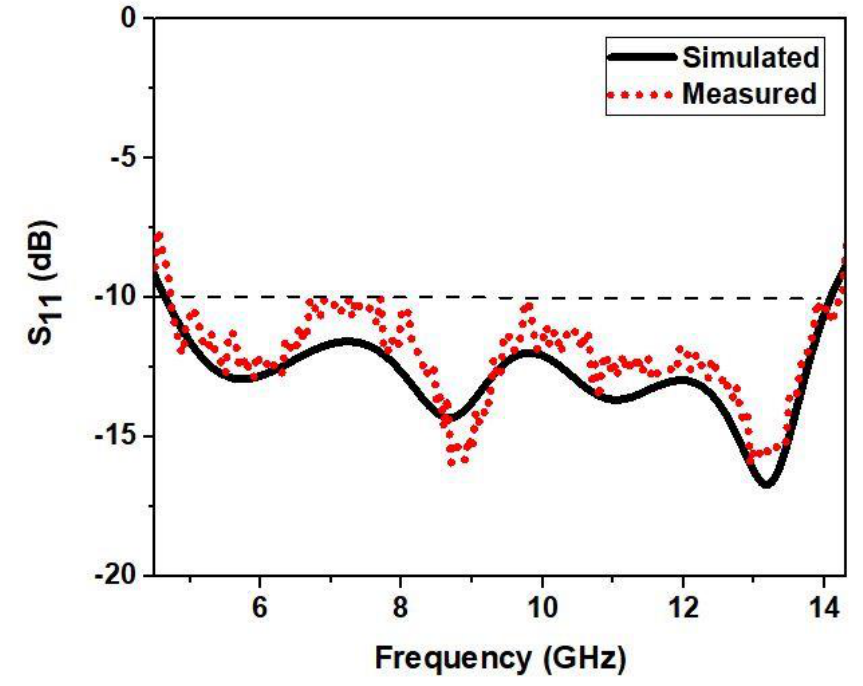
Figure 26. S 11 parameter: simulated and measured.